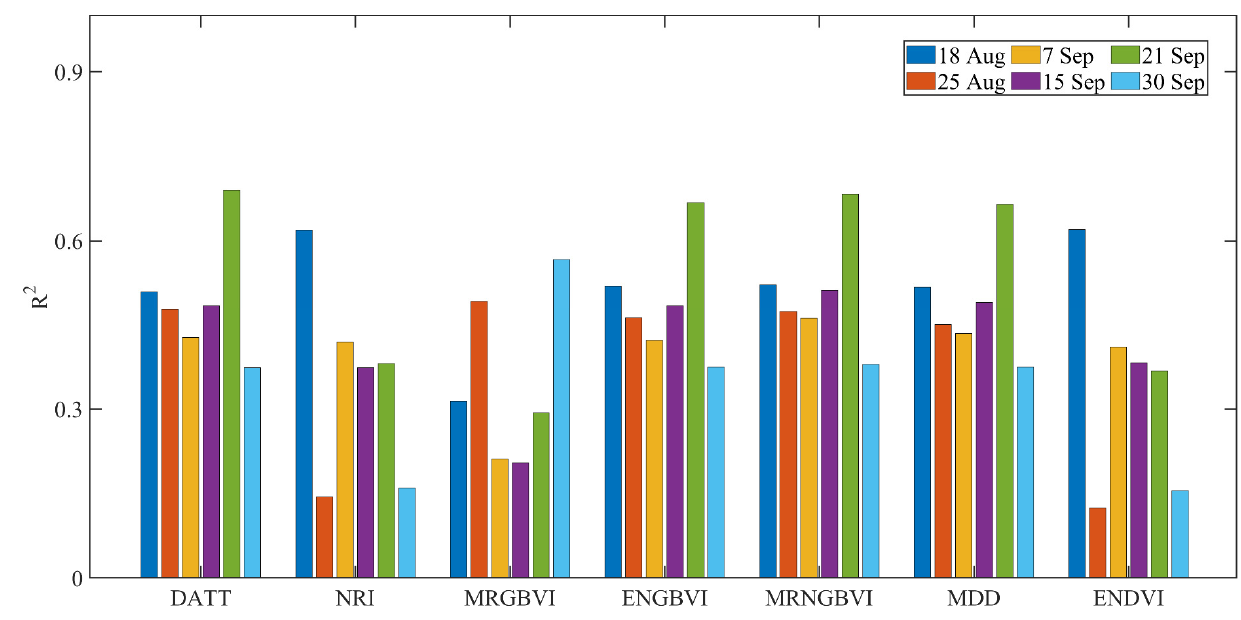
Figure 6. The R 2 of the linear regression between spectral indices and SPAD values at different growth stages of maize. The x -axis represents different spectral indices and the different colors indicate the indices calculated for different dates.